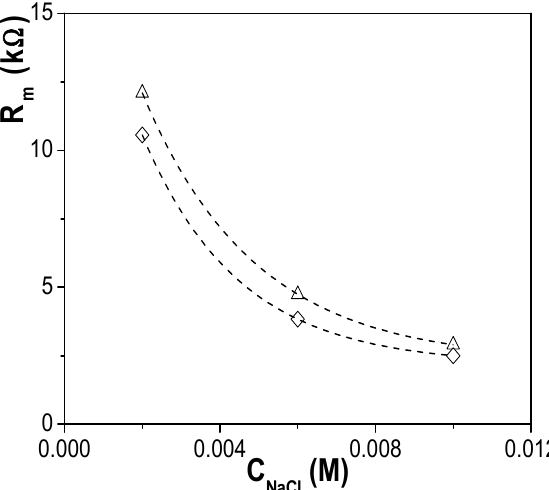
Figure 8. Membrane resistance dependence with NaCl concentration for both Ox–SiO 2 /APTES ( ♦ ) and Ox–SiO 2 /APTES/O 3 ( Δ ) membranes.